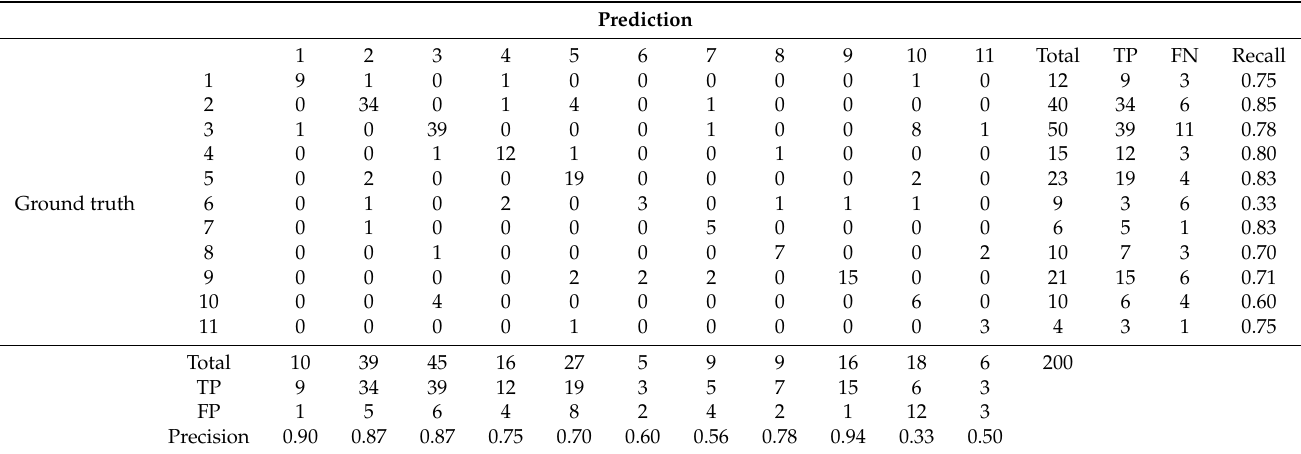
Table 3. Confusion matrix of the adopted model.